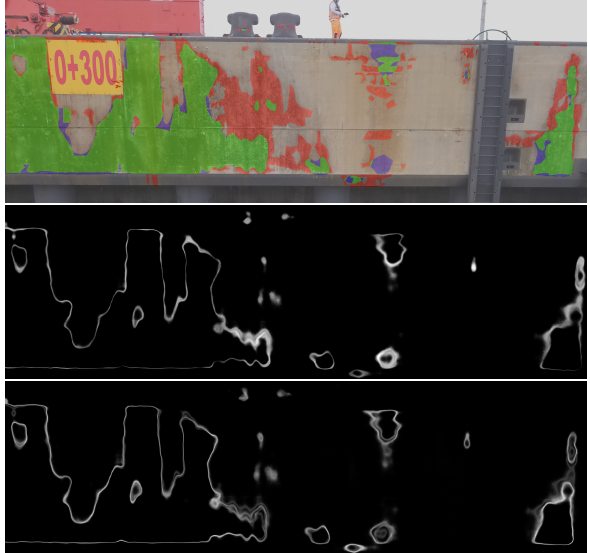
Figure 5. Cropped blending prediction by best ResNet-50 Deeplab V3+ model trained on 70 % weakly supervised images. Colour-coded in post-processing according to corrosion segments from ground truth data (green: True Positive, blue: False Positive, red: False Negative). Aleatoric and epistemic uncertainty calculated from an affiliated five instance Deep Ensemble